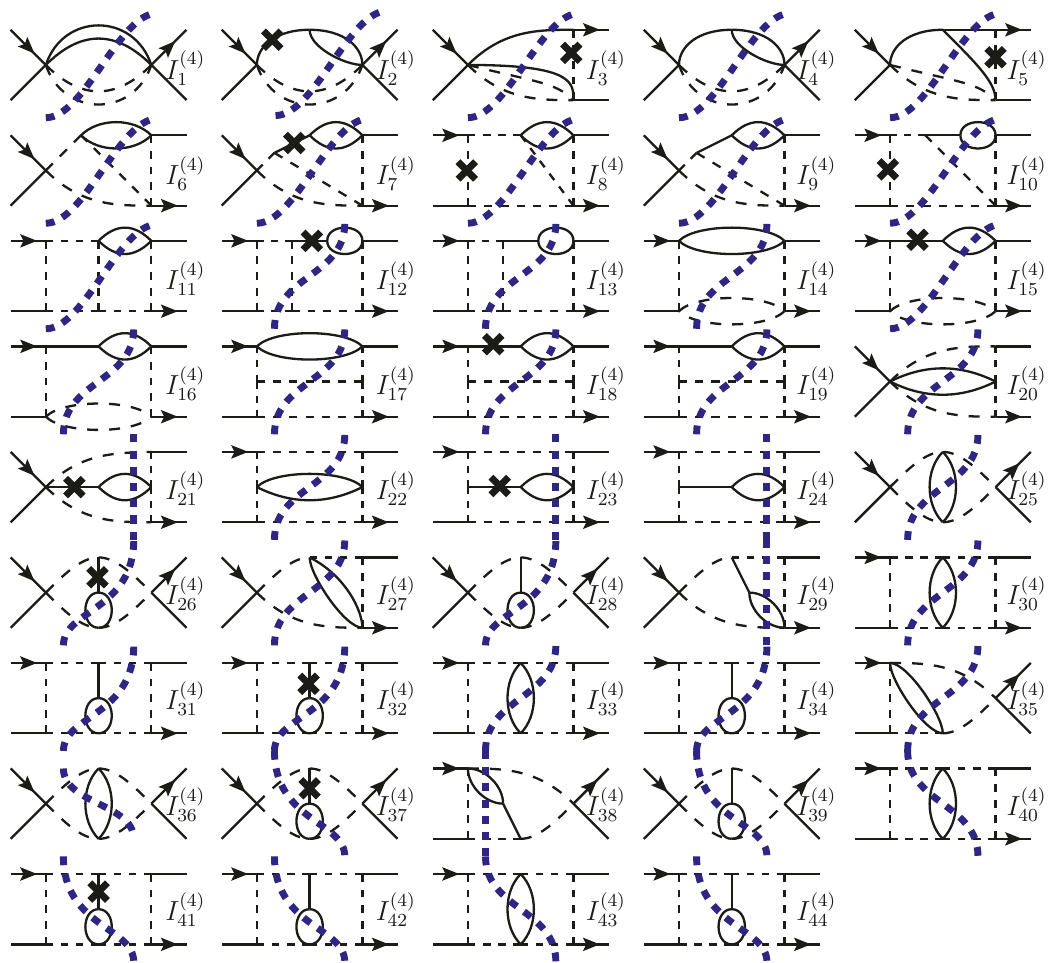
Figure 9 . Three-loop four-particle cut master integrals. Solid and dashed lines denote massive and massless lines, respectively. The blue dashed line symbolizes the cut and crosses denote propagators raised to negative power.